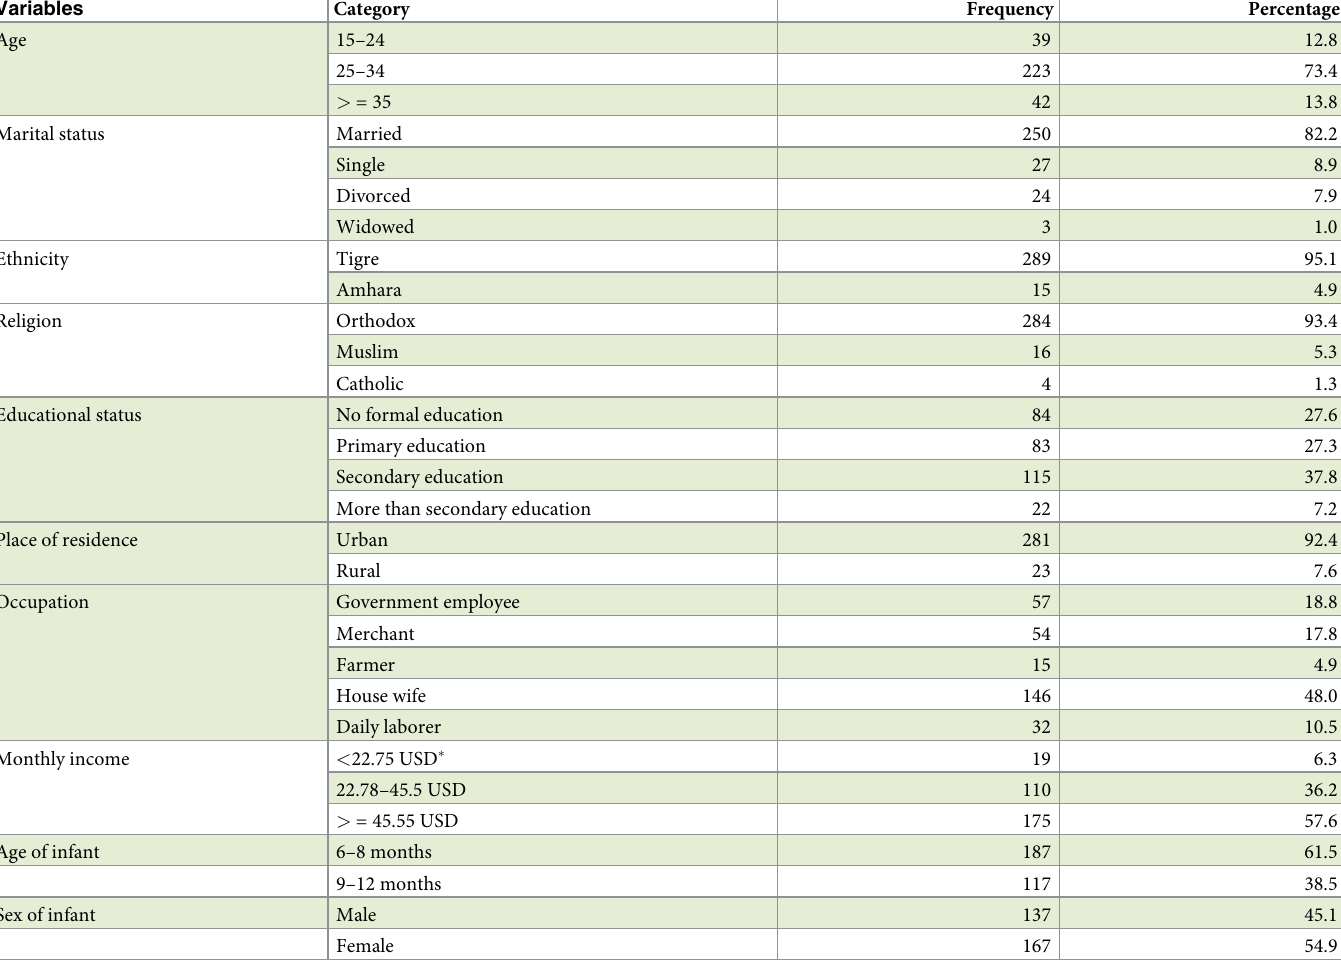
Table 1. Socio-demographic characteristics of HIV positive women visiting public hospitals of Tigray region from July to October 2016 (N = 304).